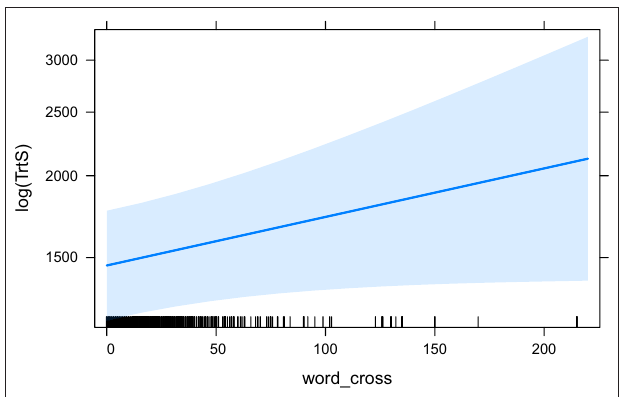
FIGURE 9 | The effect of word_cross (base model) on the logarithm of TrtS.